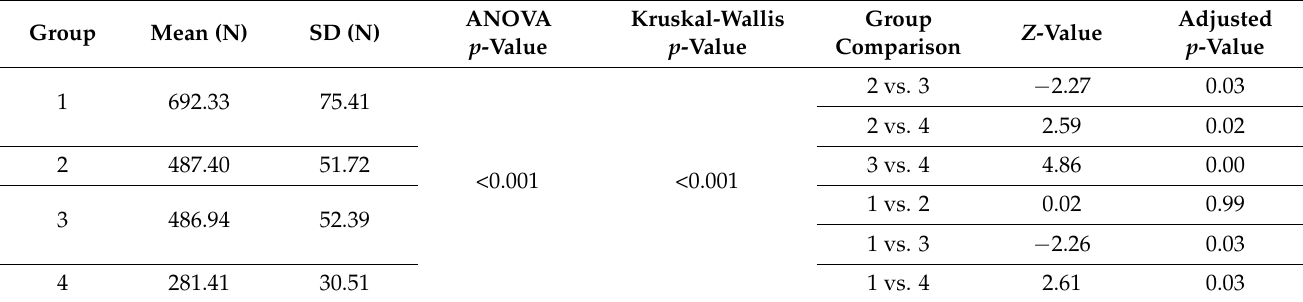
Table 2. Means, SD and statistical comparison of fracture loads among study groups.